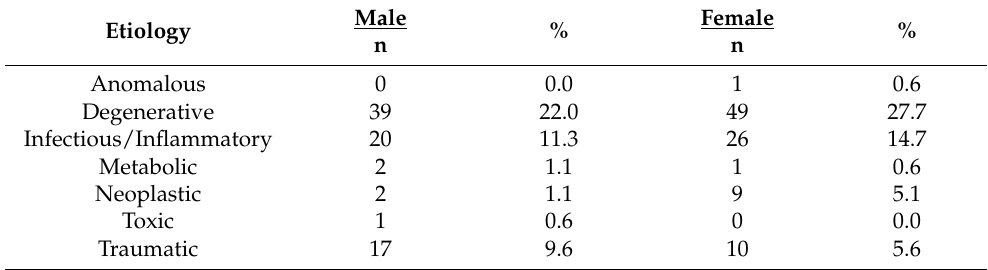
Table 2. Sex-specific